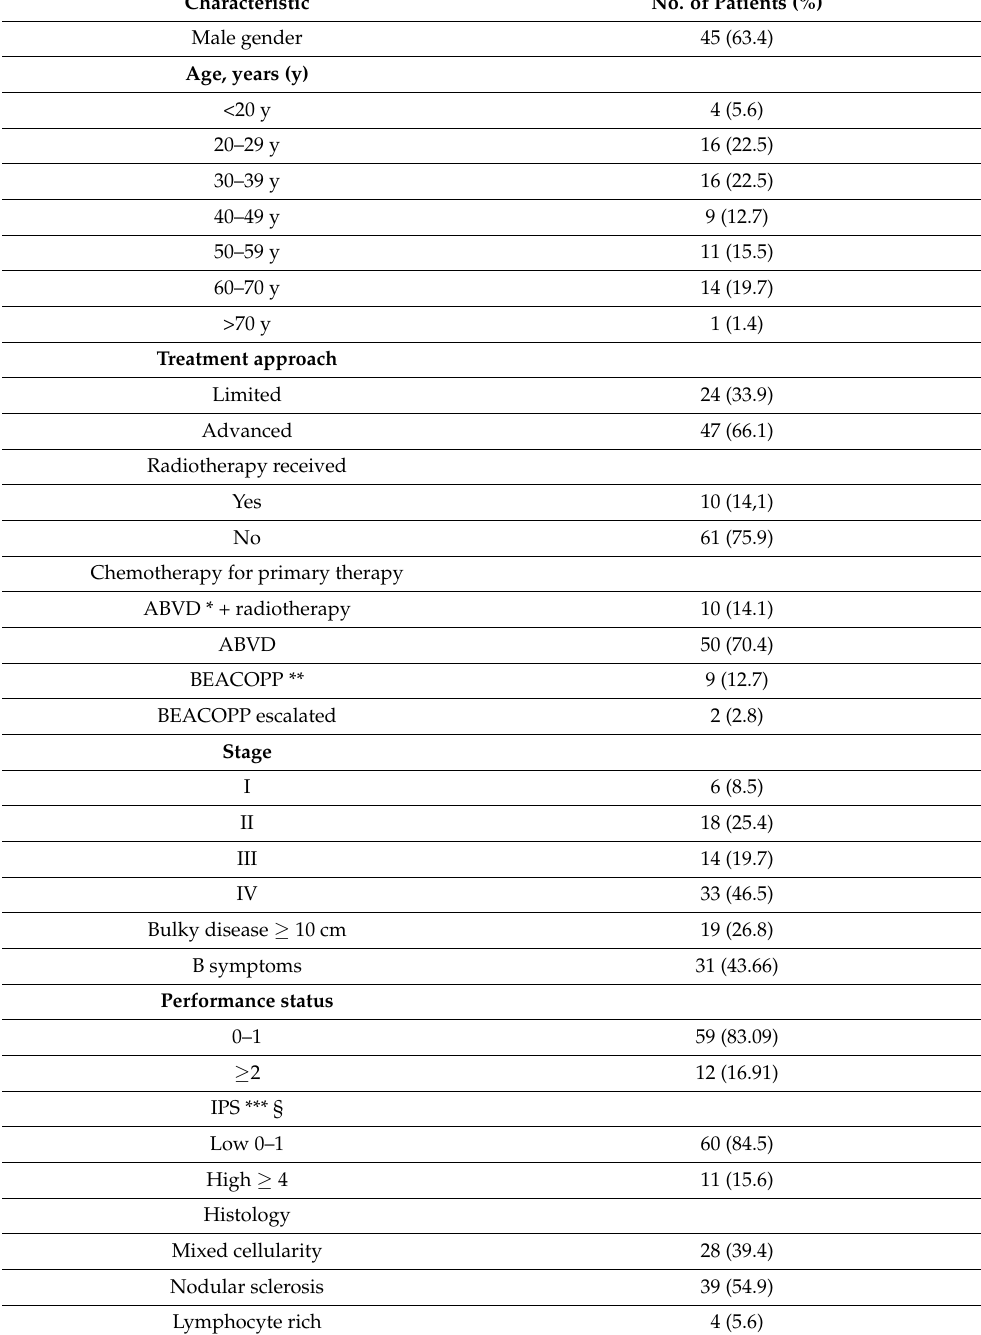
Table 1. Patient’s baseline